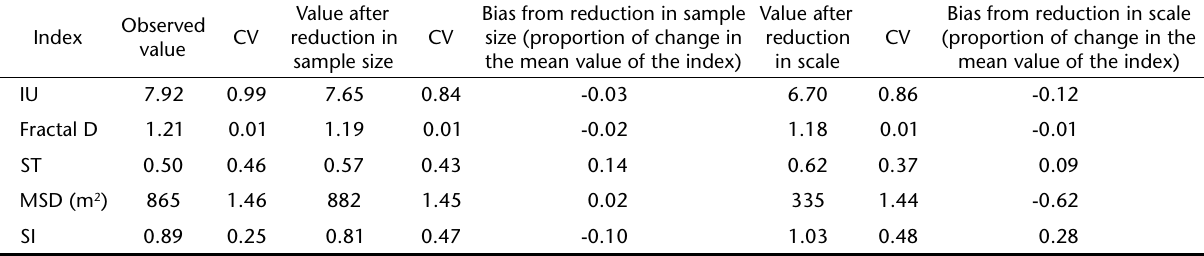
Table II. Bias produced by reduction in sample size and scale on movement indices. Index values are the means and their coefficient of variation (CV) of index values based on 149 individual paths of the marsupial D. aurita. (IU) Intensity of Use, (ST) Straightness index, (MSD) Mean Square Displacement, (SI) Sinuosity index. Reduced sample size effect was determined comparing the original path with a path of the same length but considering only alternate points along the path (same path length, but different number of points). Reduced scale effect was determined by dividing the original path in two halves, computing the index on each half, and comparing the average with the index computed on the whole path but considering only alternate points (same number of points, but different path length).